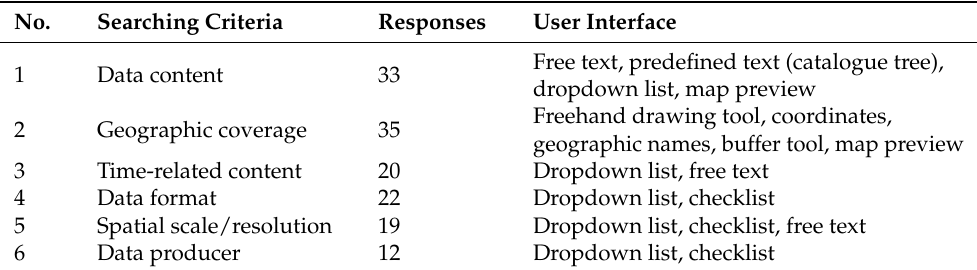
Table 7. Expert participants’ preferred interface for spatial data